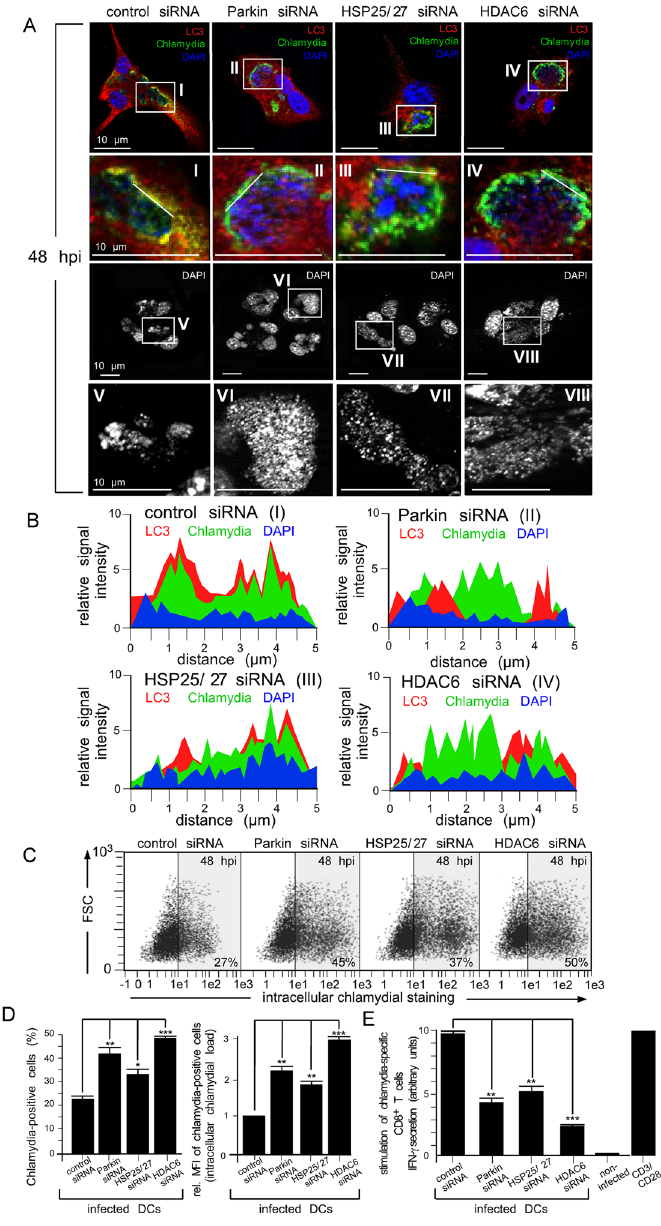
Figure 8. Silencing of aggrephagy-associated proteins increases the bacterial load and affects chlamydial antigen presentation in infected DCs. ( A ) DCs were siRNA-silenced for Parkin, HSP25/27 or HDAC6 and then infected with chlamydia. Cells were fixed and costained for LC3 (red), chlamydial LPS (green) and DNA (blue) (top panel). Enlarged photographs in the second panel from top (I, II, III and IV) show colocalisation between aggrephagy-associated proteins and chlamydial structures. The influence of siRNA silencing on the physical appearance of inclusions was visualised by DAPI (third panel from top). Enlarged photographs (lower panel, V, VI, VII and VIII) display the size and structure of inclusions. ( B ) The fluorescence intensity along a cellular cross section of interest (enlarged photographs I, II, III, and IV in ( A ) was measured. Obtained profiles were overlaid and coloured. ( C ) siRNA-silenced infected DCs (48 hpi) were analysed by flow cytometry using the IMAGEN kit. Summarised data from three independent experiments ( D ) show the number of chlamydia- positive cells, as well as the bacterial load (MFI) of infected cells. The MFI values obtained for infected cell cultures (control siRNA) were set to 1 arbitrary unit. ( E ) DCs were siRNA-silenced for Parkin, HSP25/27 or HDAC6 and infected with chlamydia. AllStars siRNA, non-infected cells and CD3/CD28 beads were used as controls. DCs were cocultured with chlamydia-sensitised CD8 + T cells for 48 h. IFN- γ secretion by CD8 + T cells was assayed by ELISA. Relative values of IFN- γ secretion are expressed in arbitrary units (maximum value was set to 10) and are the means ± SD of three independent experiments. Statistical analysis in ( D and E ) was performed as described in Methods ( * p < 0.05; ** p < 0.01; *** p < 0.001; n =